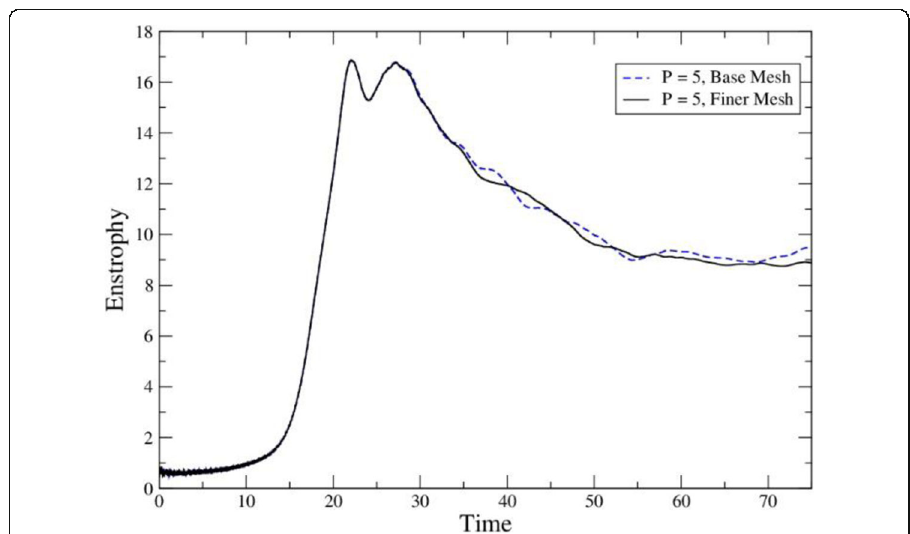
Fig. 4 Histories of enstrophy for two p = 5 simulations on the base and finer meshes